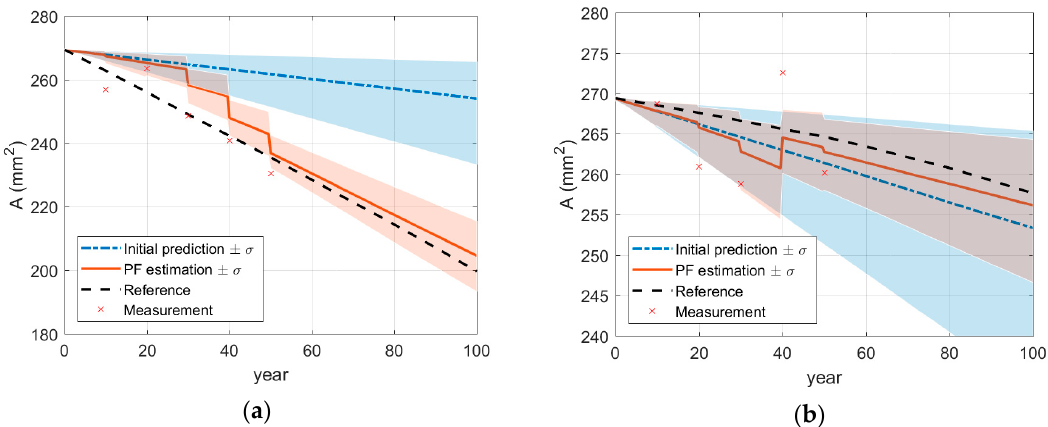
Figure 5. Monitoring and prediction of cross-section by particle filter at specific locations: ( a ) at point A; ( b ) at point